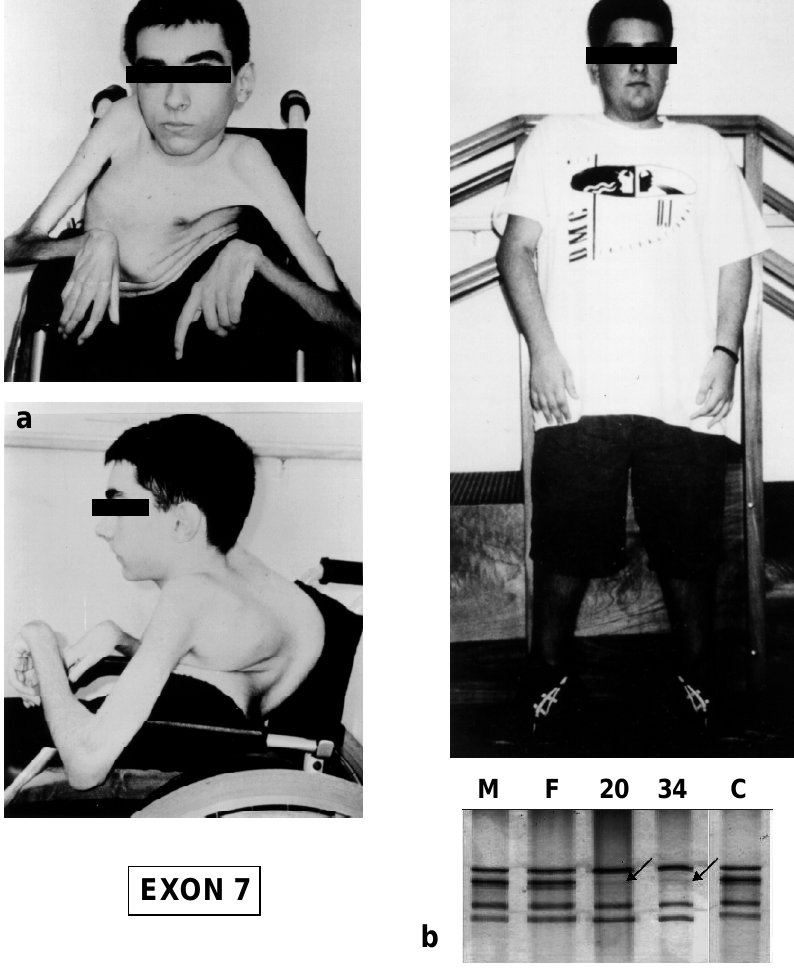
Figure 1 - a, Brothers affected with SMA types II and III. b, Molecular analysis of exon 7 of SMN gene. M - Mother, F - father, cases 20 and 34, and C -